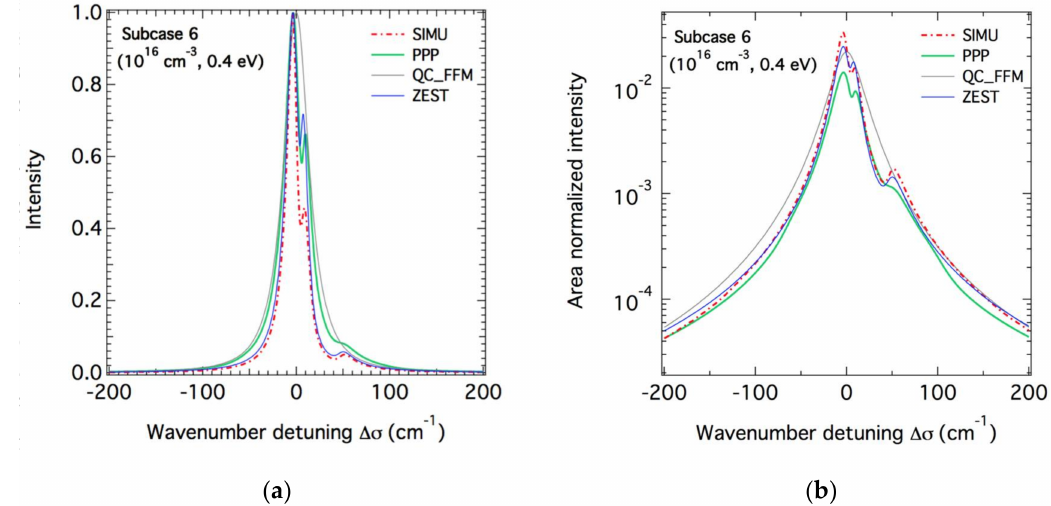
Figure 6. Same as Figures 4 and 5 with the same line styles and code colors but for T e = T i = 0.4 eV.